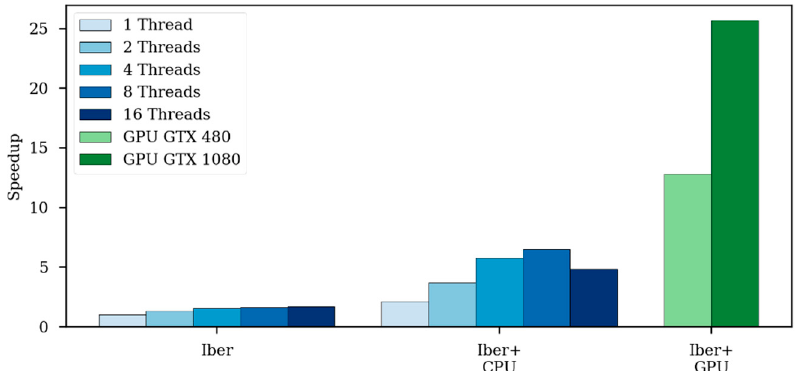
Figure 8. Speedups obtained comparing Iber running in one thread with different configurations in Test 2.